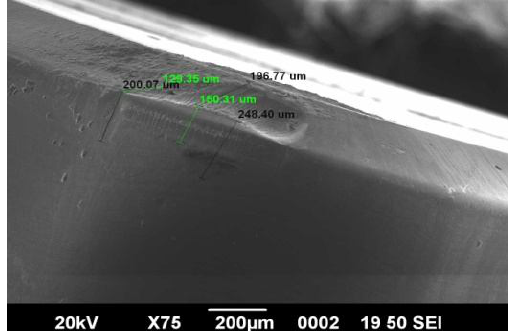
Fig.2. SEM micrograph at v = 150 m/min, f = 0.15 mm/rev and t = 20